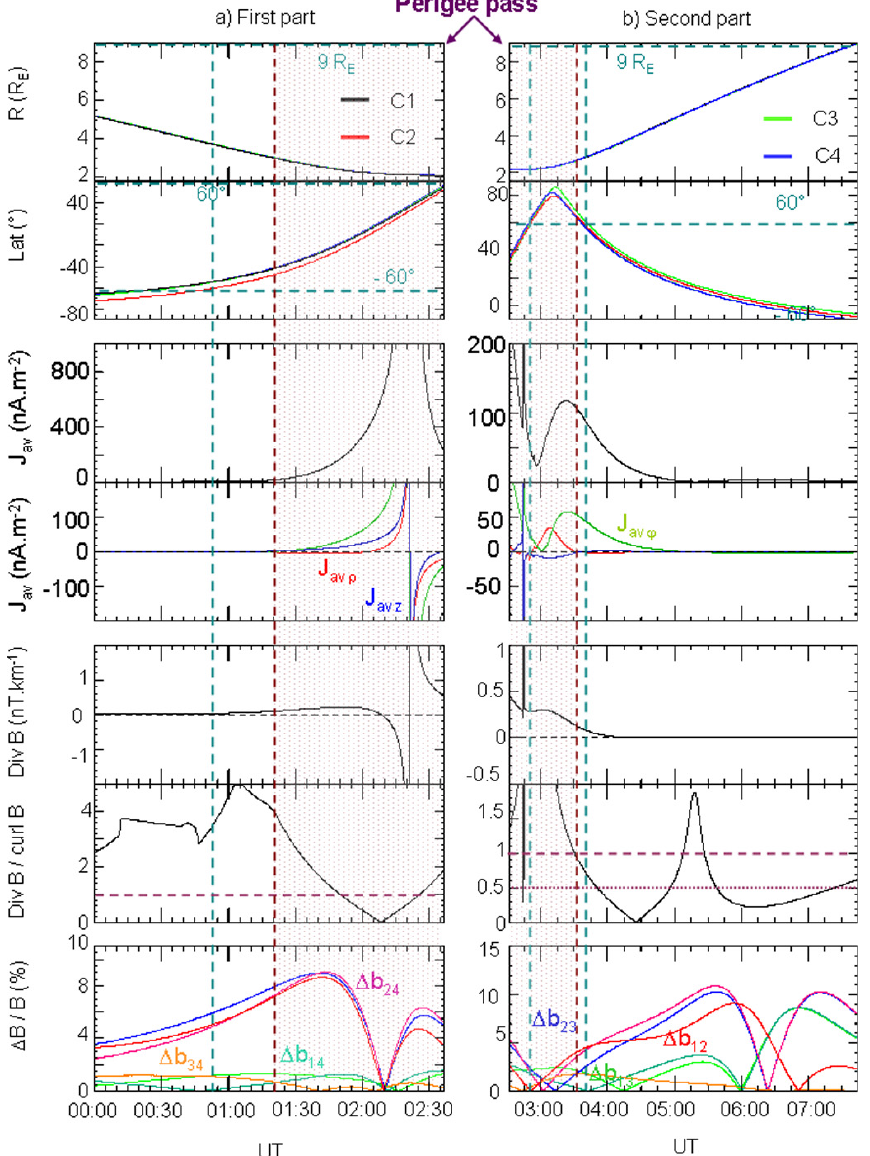
Fig. 11. Study of the accuracy of the curlometer technique for the Tsyganenko magnetic field calculated along a modelled orbit with 200km